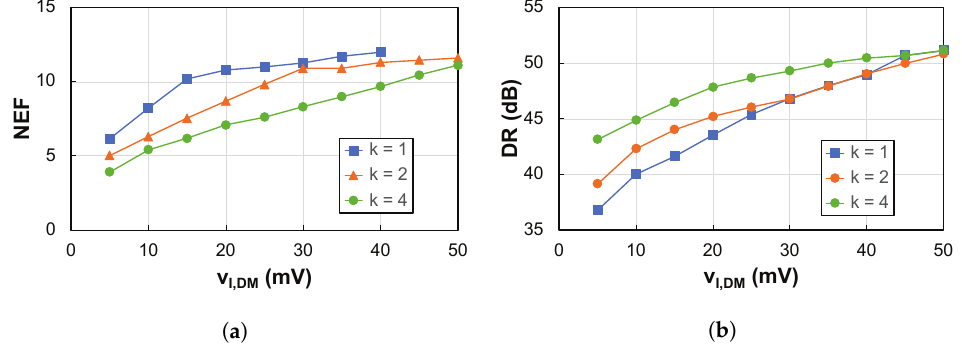
Figure 6. Simulated ( a ) NEF and ( b ) DR as a function of the input DM